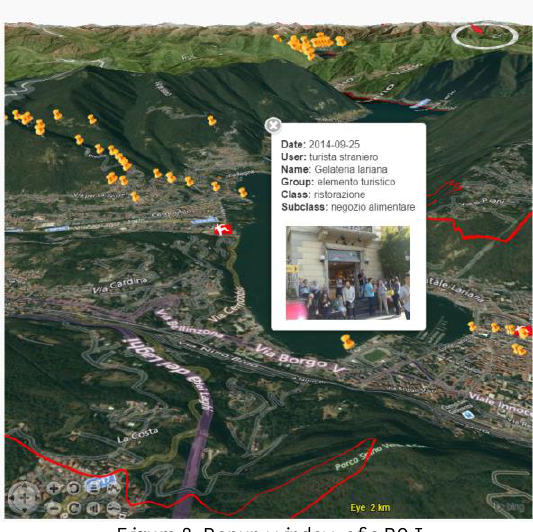
Figure 8. Popup window of a